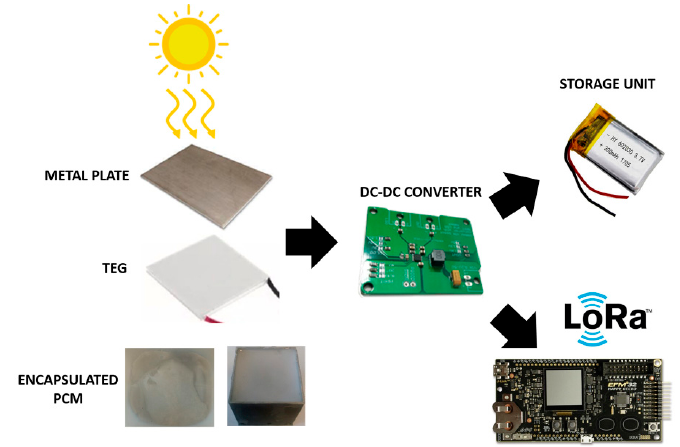
Figure 15. TEH prototype (block diagram).